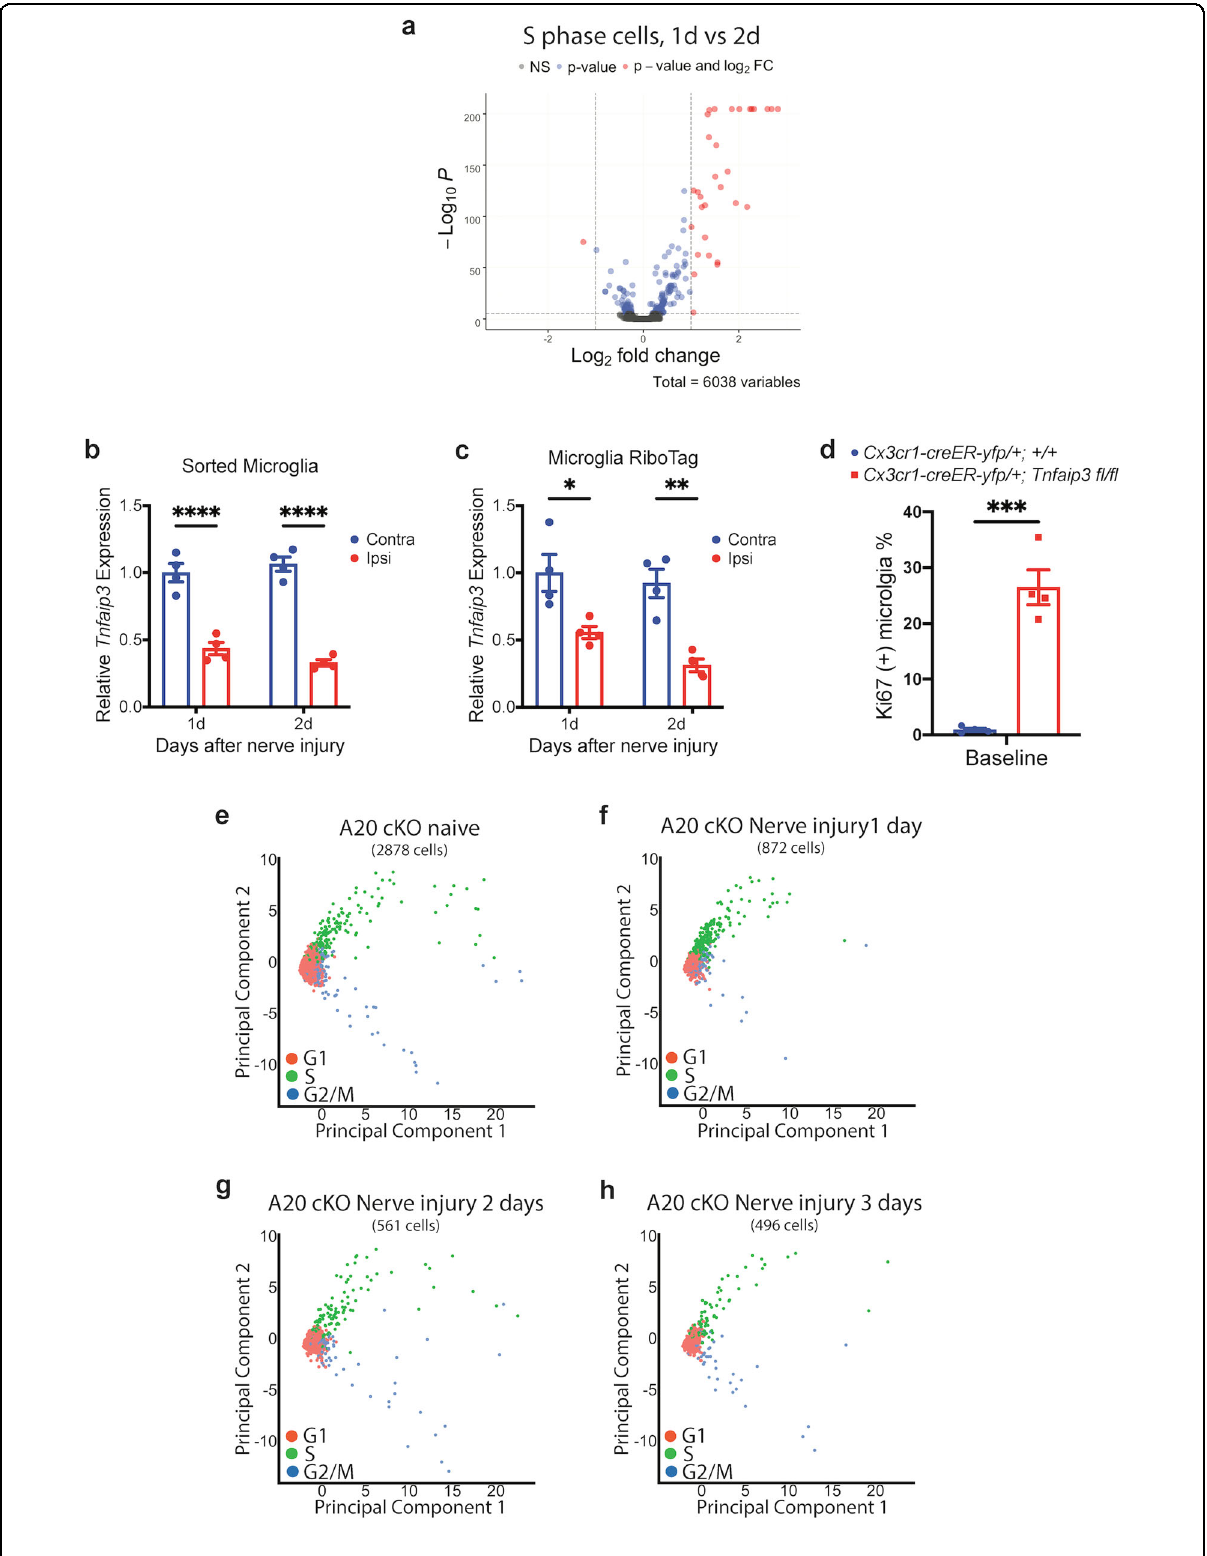
Fig. 3 (See legend on next